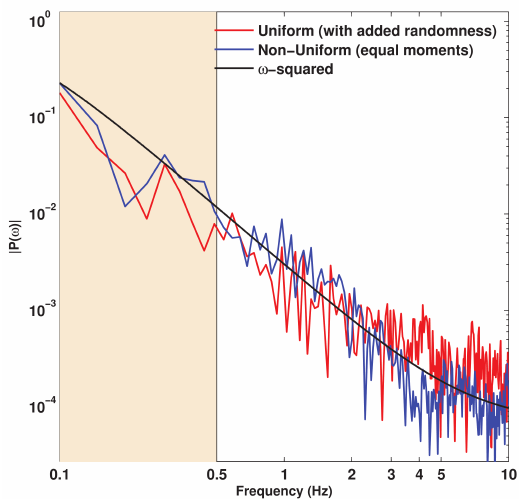
Figure 21. Comparison of the amplitude spectra of the transfer functions [p(t)] for the 1999 Hector Mine earthquake. EGF magnitude: 3.0. Black line: Theoretical value. Red line: Uniform distribution. Blue line: Non-uniform distribution used in this study.